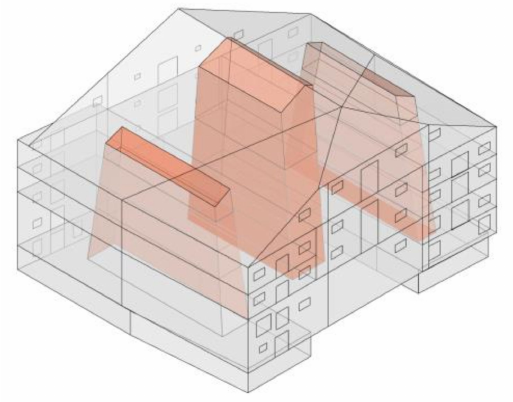
Figure 10. Configuration of atriums after optimization in Scenario 3.